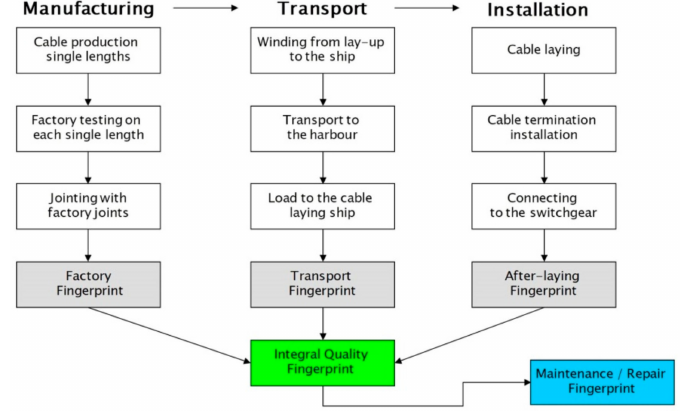
Figure 1. Integral fingerprint for quality control during the manufacturing, transportation, and installation of o ff shore power